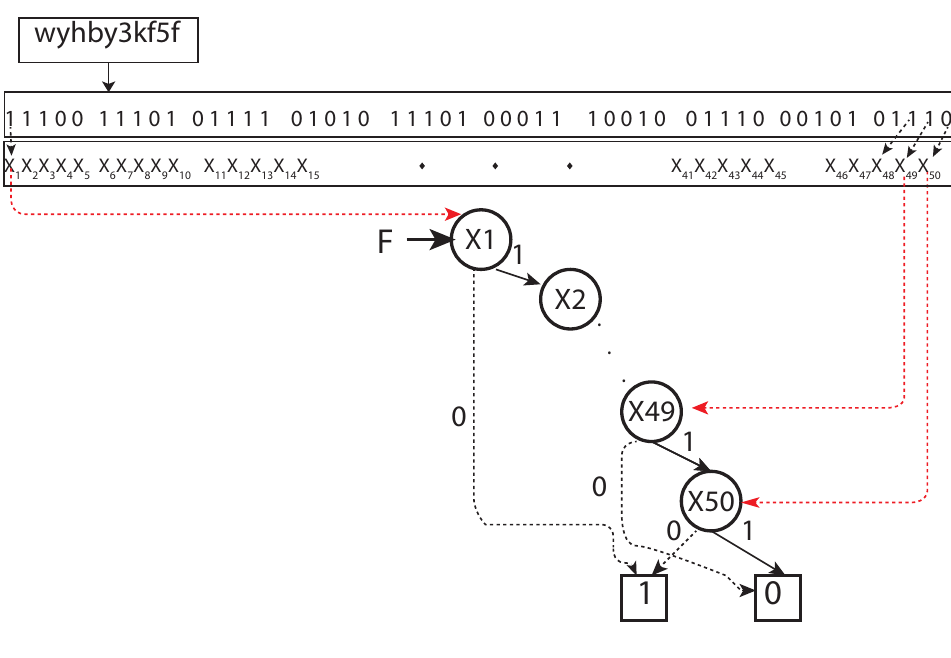
Figure 3. BDD representation for a unit